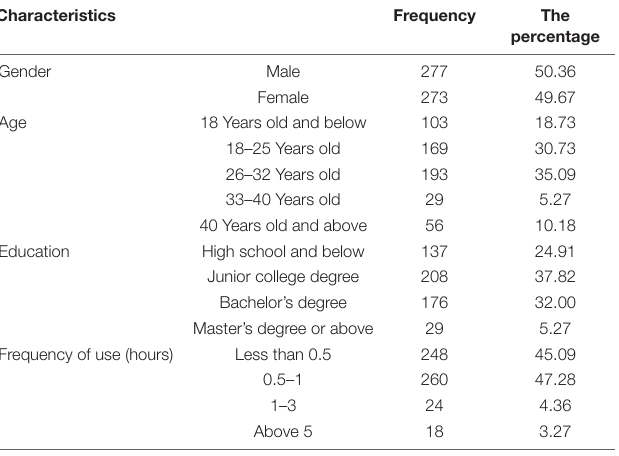
TABLE 1 | Descriptive characteristics of the sample ( N = 550). Characteristics